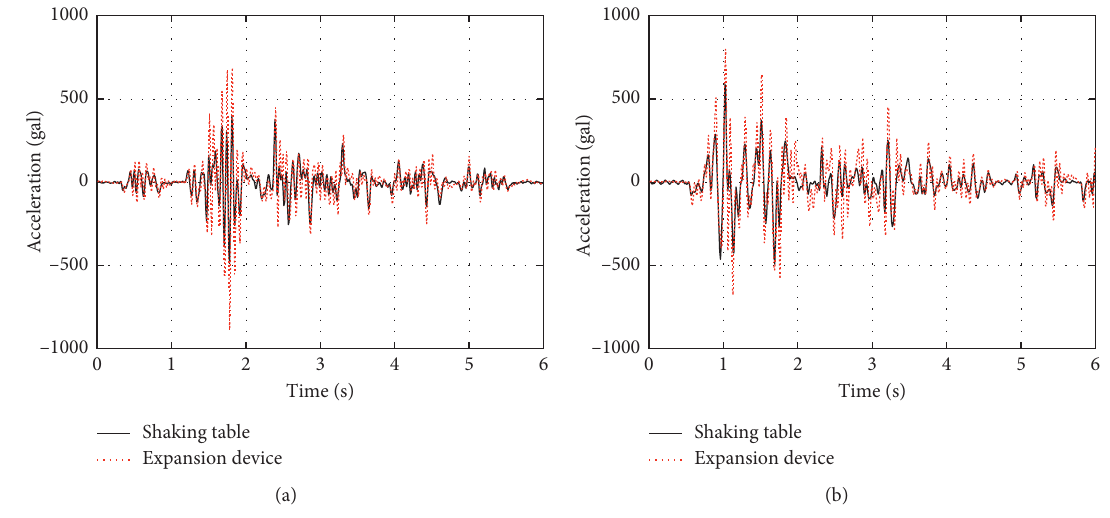
Figure 5: The comparison time history curves between shaking table and expansion device. (a) IVE-500. (b) ELC-500. Table 2: The comparison peak acceleration between shaking table and expansion device.